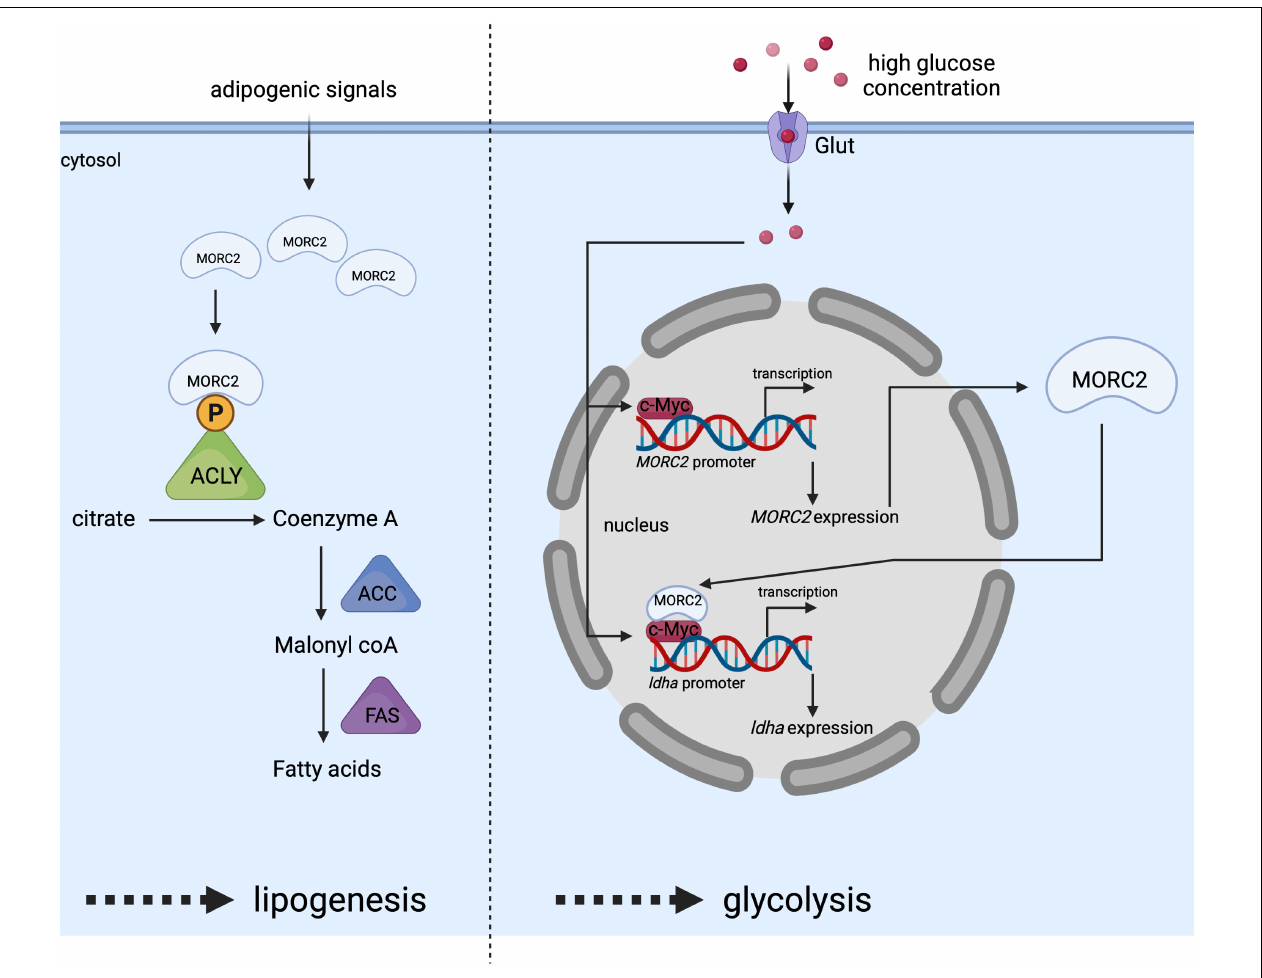
FIGURE 6 | Schematic representation of MORC2 as a key regulator of lipogenesis (left side) and glycolysis (right side) pathway. Adipogenic signals increase MORC2 protein levels facilitating the interaction between MORC2 and ACLY in the cytosol, and leading to the activation of ACLY by preventing its dephosphorylation. This activated ACLY is essential for increased fatty acid synthesis. High glucose concentration in the culture medium stimulates the induction of MORC2 expression. Once, MORC2 is induced, it forms a complex with c-myc and gets recruited to LDHA promoter to induce LDHA expression, which in turn facilitates